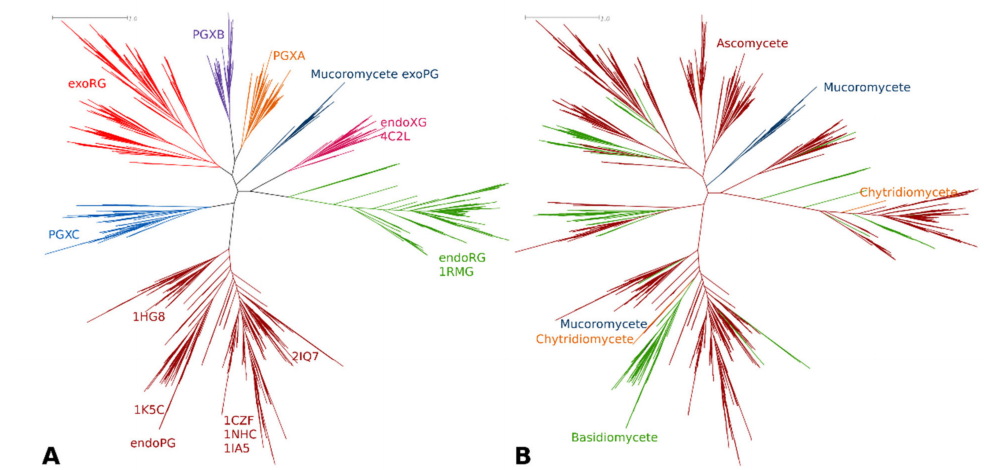
Figure 3. Phylogenetic relationship, functional clustering and taxonomic distribution of fungal GH28 enzymes. ( A ) Colors of clusters as in Figure 2. Sequences with resolved structures are indicated by their PDB identifier; ( B ) Taxonomic distribution of GH28 enzymes. For details per subfamily see Table 1 and Supplemental Figure S2. The scale bar indicates the number of amino acid substitutions per site. The tree was constructed using the LG model, four fixed rate classes and a gamma shape parameter of